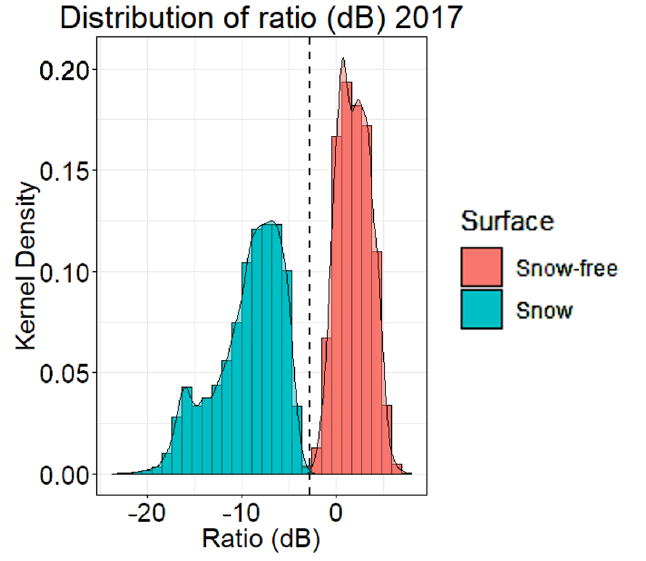
Figure 4. Distribution of Ratio values (dB) in snow covered and snow-free